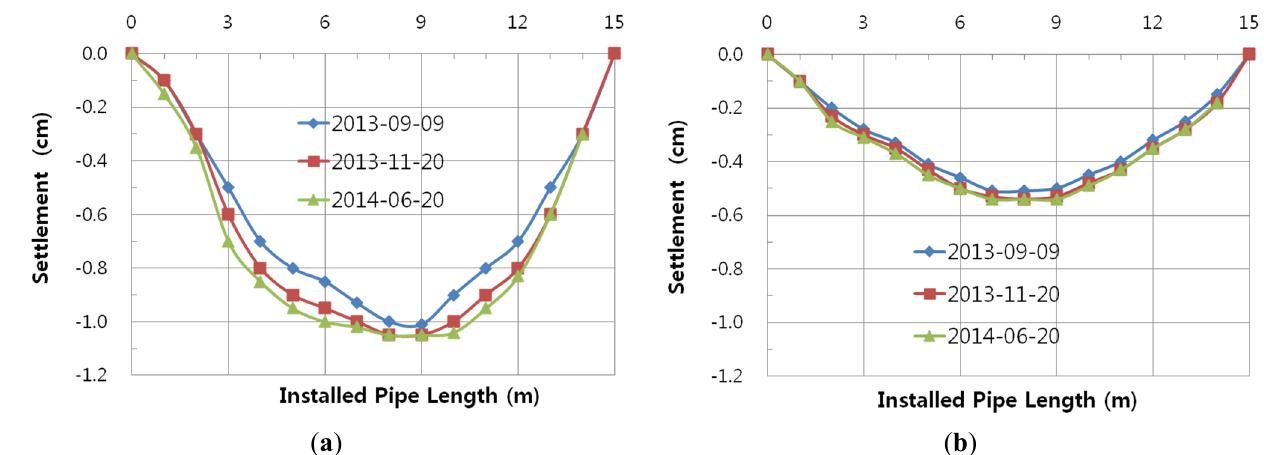
Figure 6. Measured settlement of Pipe. ( a ) Case B1; ( b ) Case B2.